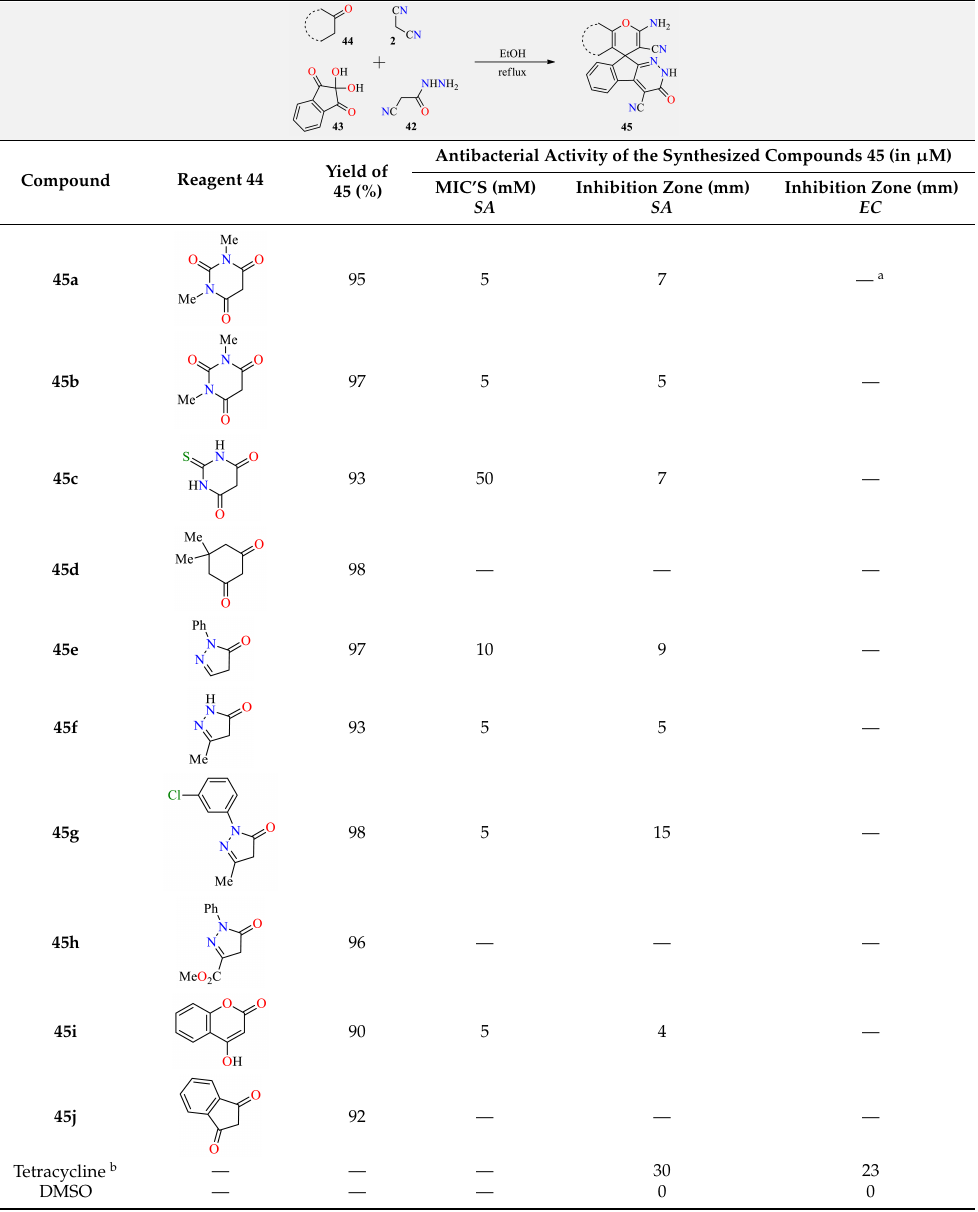
Table 10. Multicomponent synthesis and antimicrobial activity of spiroindenopyridazine-4 H -pyrane derivatives 45